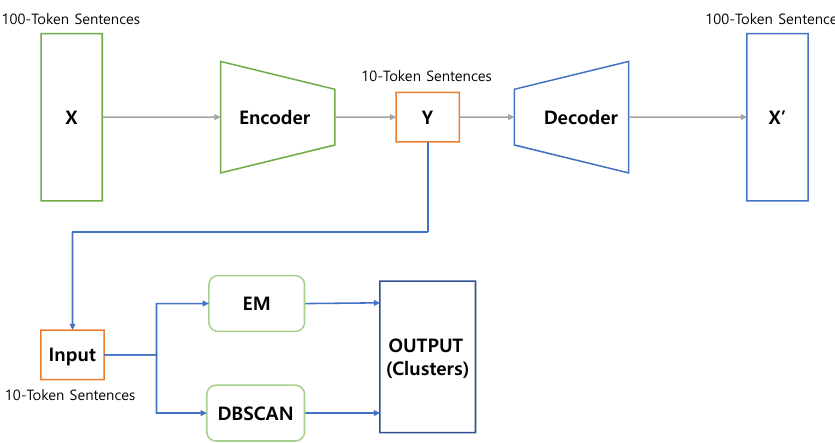
Figure 5. The architecture of the unsupervised clustering techniques used to identify the number of natural